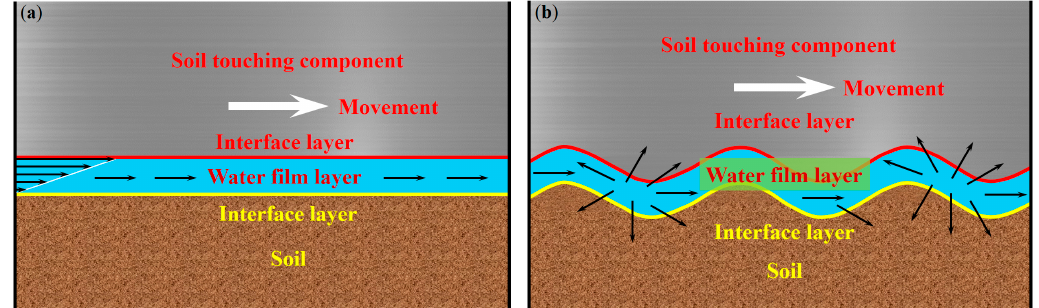
Figure 4. Schematic diagram of five-layer interface model: ( a ) Smooth surface; ( b ) Non-smooth surfaces.